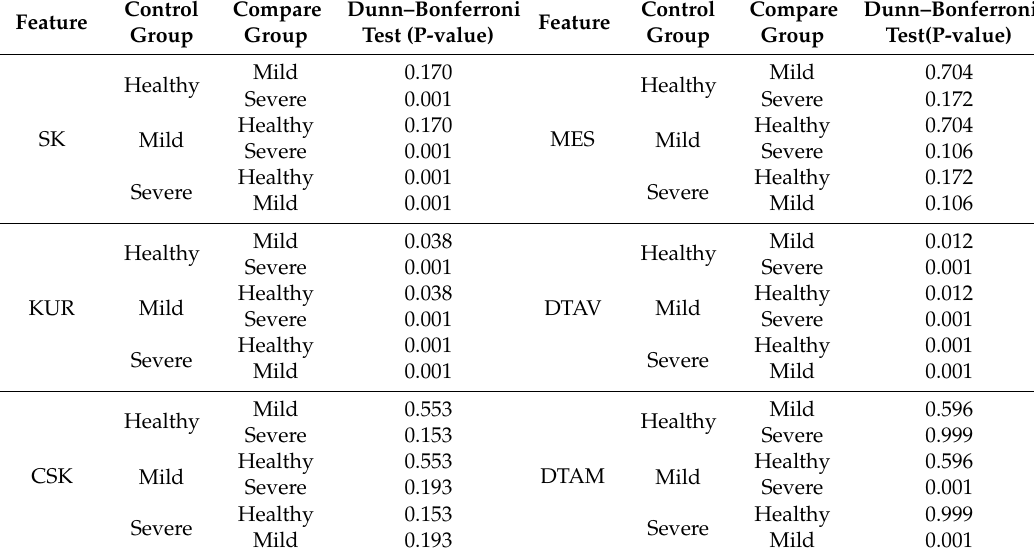
Table 3. The Dunn–Bonferroni test results between healthy, mild (HYS Stage 1 to Stage 3), and severe (HYS Stage 4 and Stage 5) (n = 202).